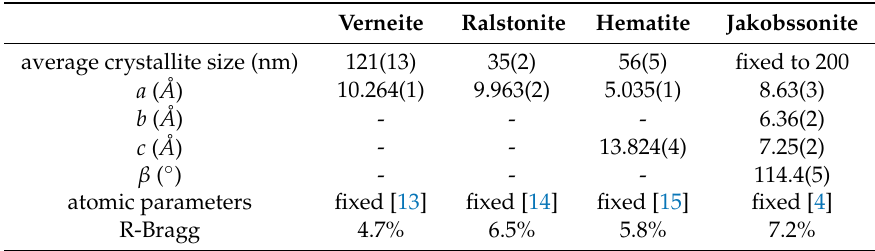
Table 2. Rietveld refinement results. “Mineral HB” [1], also present in the sample, was not included in refinement because structural details are unknown. Average crystallite size modelled by Lorentzian function. Global parameters: R exp = 6.58%, R wp = 11.6%, GoF = 1.76, profile function: Fundamental